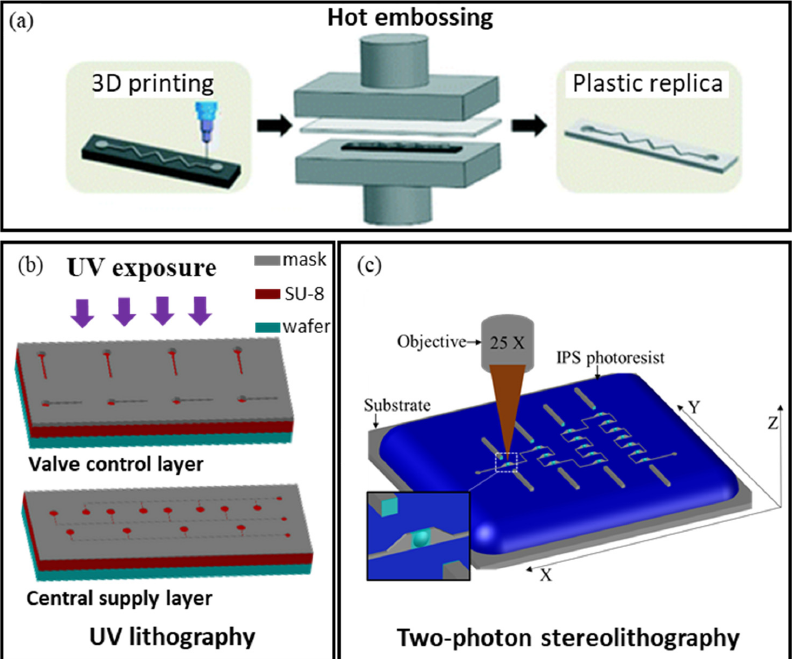
Figure 2. Mold replication for fabricating optofluidic devices. ( a ) Metal 3D printing for mold fabrication and hot embossing for replicating mold structures. ( b ) UV lithography for mold fabrication. ( c ) Two-photon stereolithography for mold fabrication and PDMS casting for replicating mold structures. ( a ) Reprinted with permission from ref [27], Copyright 2017, Royal Society of Chemistry; ( b ) Reprinted with permission from ref [28] Copyright 2021, American Chemical Society; ( c ) Reprinted with permission from ref [33], Copyright 2021, Royal Society of Chemistry.